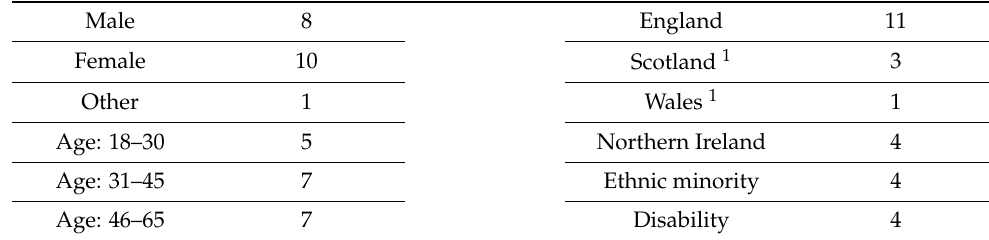
Table 1. Dialogue participant